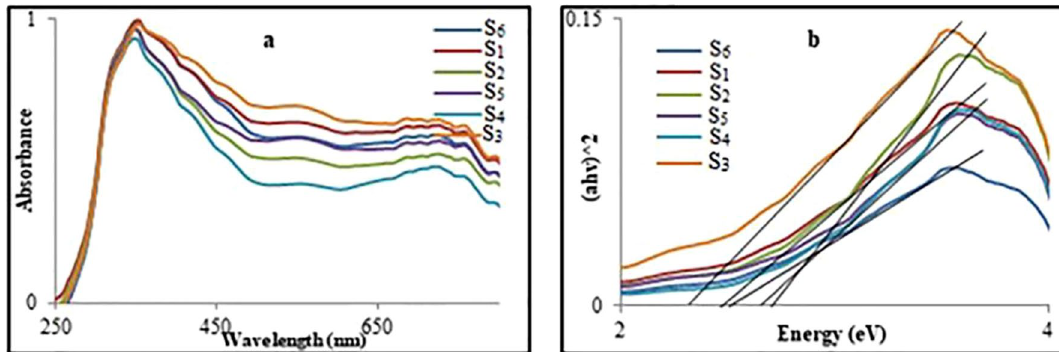
Figure 5. UV–Vis spectra ( a ) and NiO nanocatalyst band gap energy ( b ).